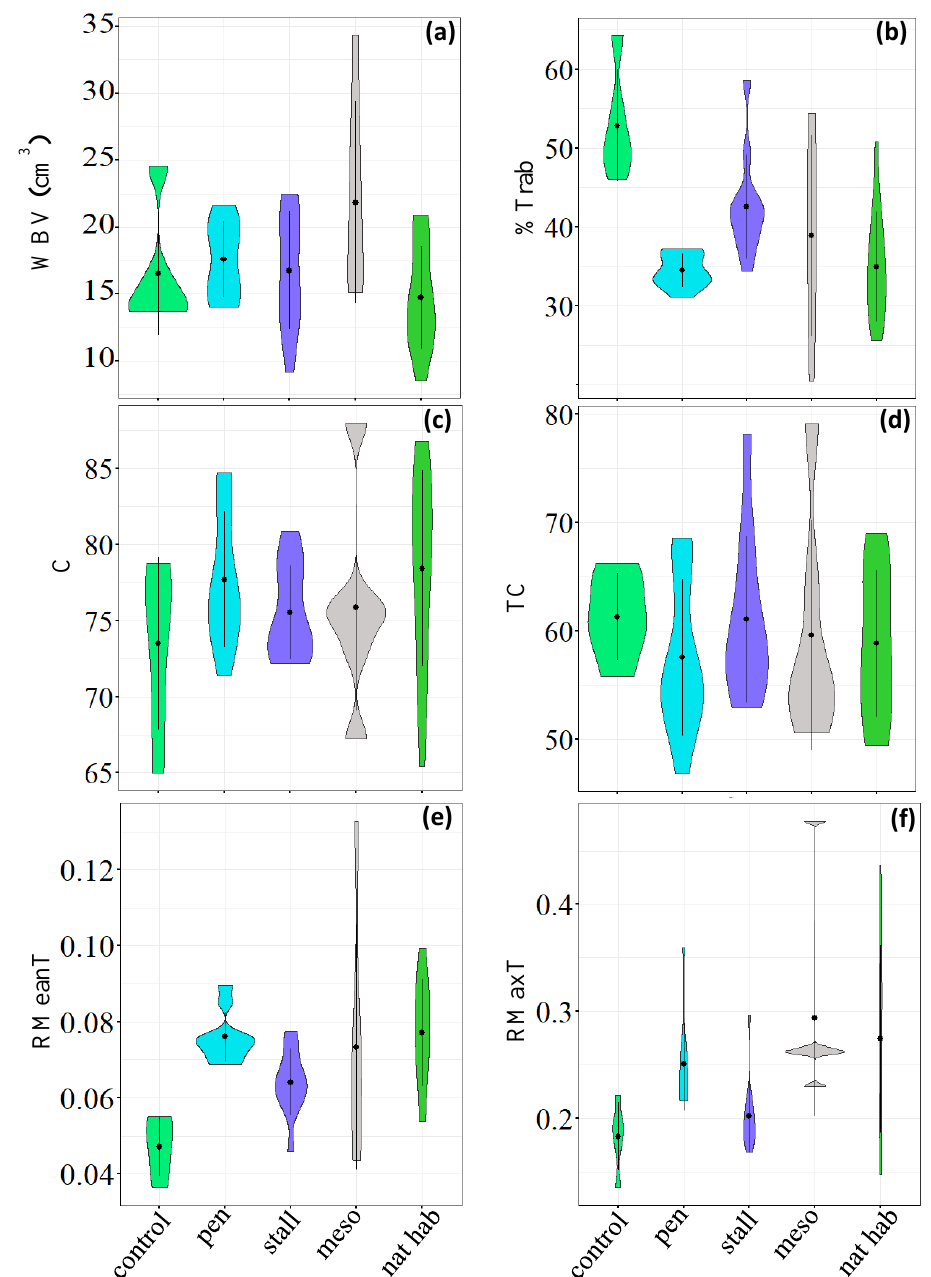
Figure 6: Calcaneus microanatomical variation in Sus scrofa from experimental populations and Mesolithic contexts. WBV, whole bone volume; RMeanT, relative mean cortical thickness; RMaxT, relative maximum cortical thickness; C, compactness ratio; TC, trabecular compactness ratio; %Trab, percentage of trabecular bone volume to cortical bone volume. meso, Mesolithic; nat hab, Natural